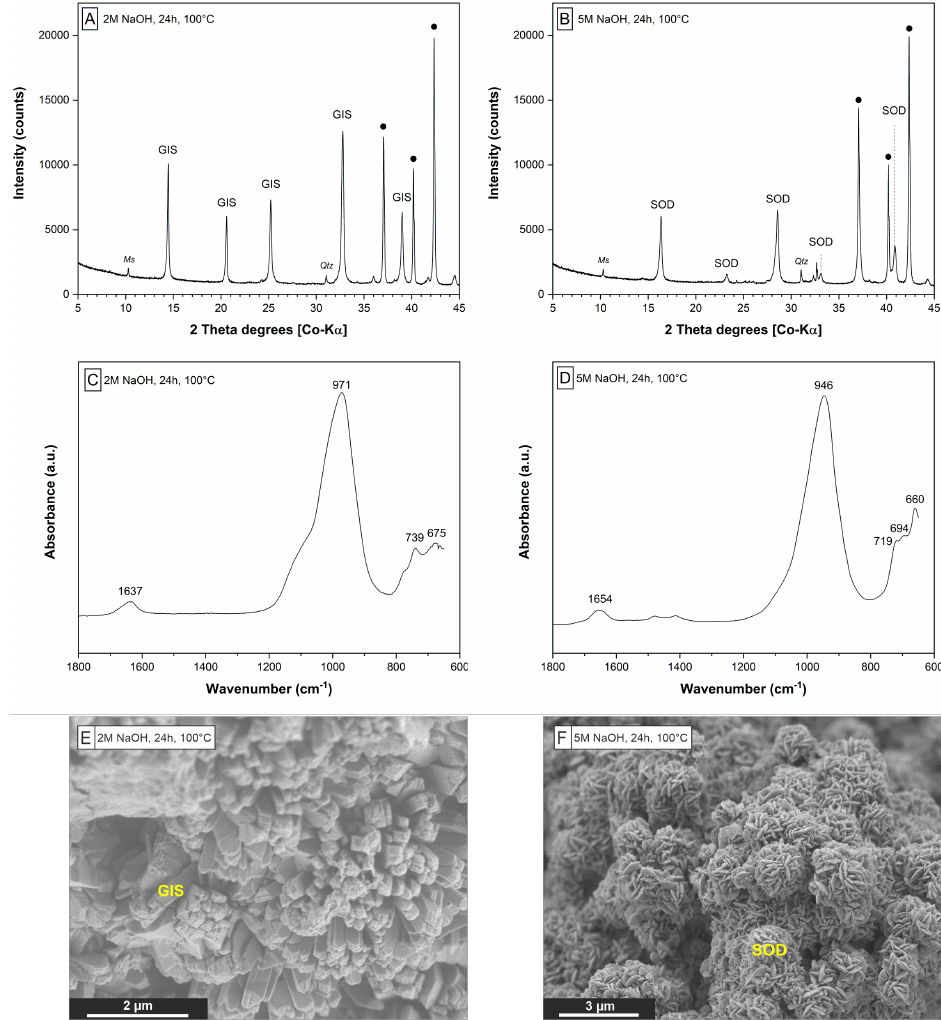
Figure 4. Characterization of zeolites obtained from the hydrothermal extraction step 1. XRD patterns ( A , B ), FTIR spectra ( C , D ) and SEM-SEI ( E , F ) of solids obtained from experiments E2 (left column) and E4 (right column) show GIS and SOD are the main zeolites precipitated. • —marks the peaks derived from the internal zincite